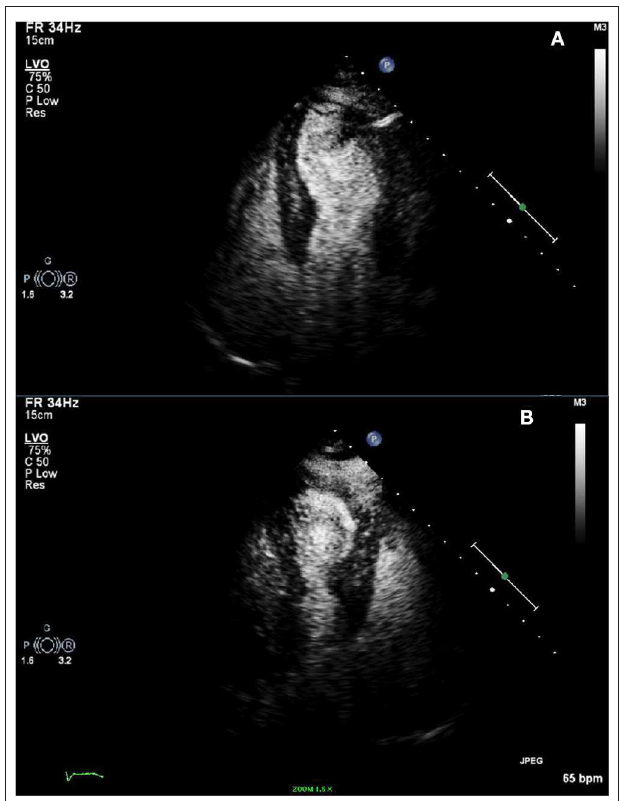
FIGURE 4 | (A,B) Transthoracic echocardiogram with definity contrast demonstrating hypercontractility of the basal wall and akinesis of the mid to distal anteroseptal wall, anterior wall, mid to distal inferior and inferolateral walls, and